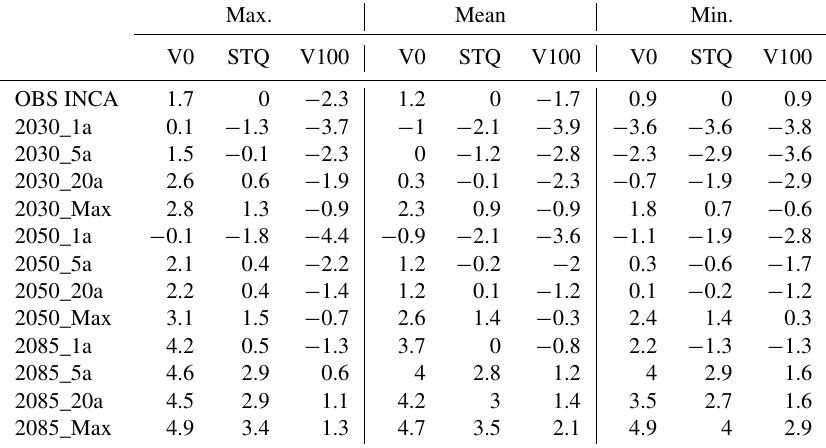
Table 4. Differences between the 20a event of the OBS period (2013) (with mean low flow discharge) of predicted maximum, mean and minimum water temperatures for the 1a, 5a, 20a and Max events at DFS 39km for the climate periods centred on 2030, 2050 and 2085 for vegetation scenario V0 (no vegetation), STQ (vegetation unchanged) and V100 (maximum